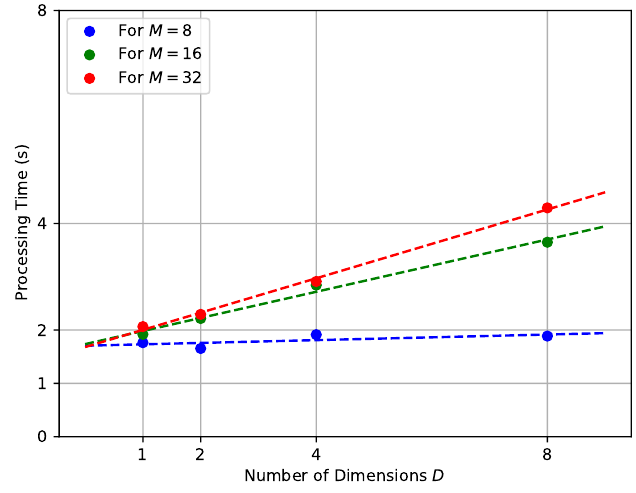
Figure 14. Best polynomial function that fits processing time for different values of number of dimensions, D